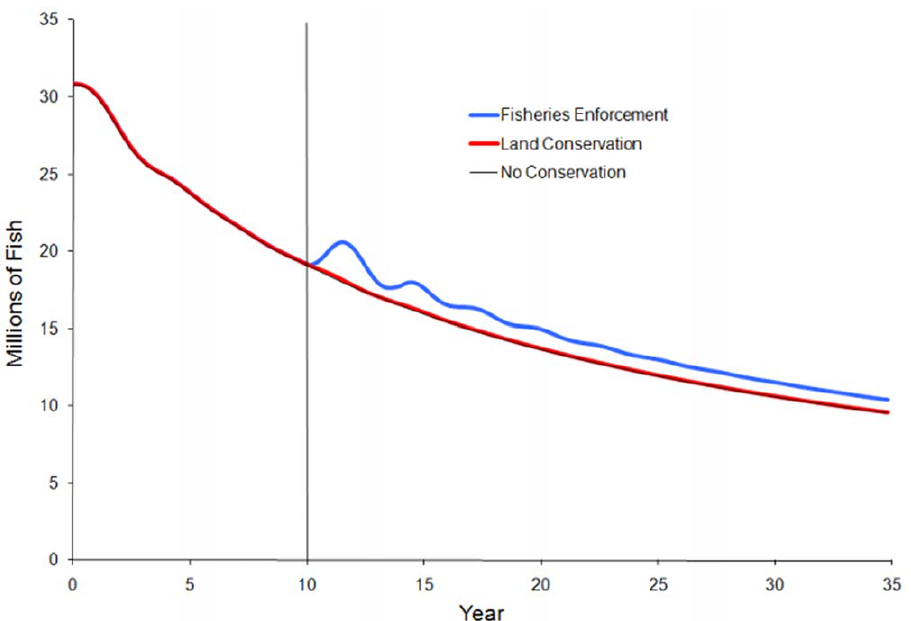
Figure 5. Marine conservation strategies on fish stock when the stock is declining. Fish stock is modeled as declining due to an increase in the catchability coefficient, representing improving fishing technology, with conservation strategies being implemented at 10 years, denoted by the